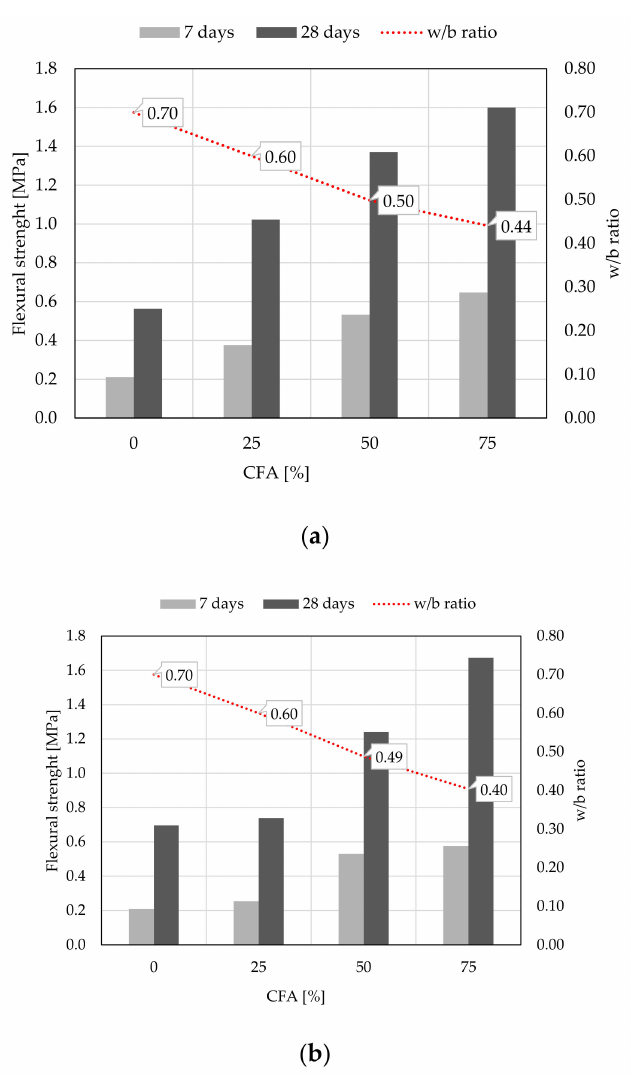
Figure 9. Flexural strength of mortars: ( a ) WBA1 and CFA binders, ( b ) WBA2 and CFA binders. Capillary absorption was observed over time as a function of weight gain, Figure 10. All samples with WBA have a pronounced initial absorption over a period of 10 min, followed by a smaller weight gain until the next measurement after 90 min. After 90 min, water was visible on the top of the sample, indicating complete saturation. After 24 h, these samples were cut in half and water saturation was shown to be complete. With the increase in CFA content, decreased water absorption was demonstrated. These results are consistent with increased mortar density. Slightly better results exist for WBA2 mixes, which is also confirmed by the calculated water absorption coefficients for ordinary mortar (c m ), Figure